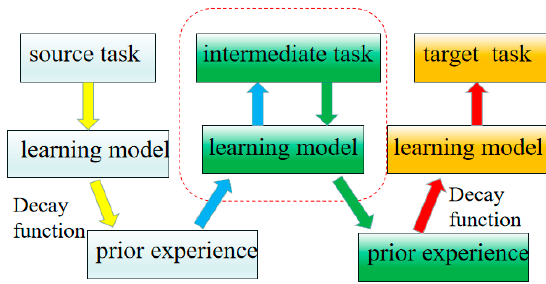
Figure 5. Curriculum transfer learning with an intermediate task and decay function.